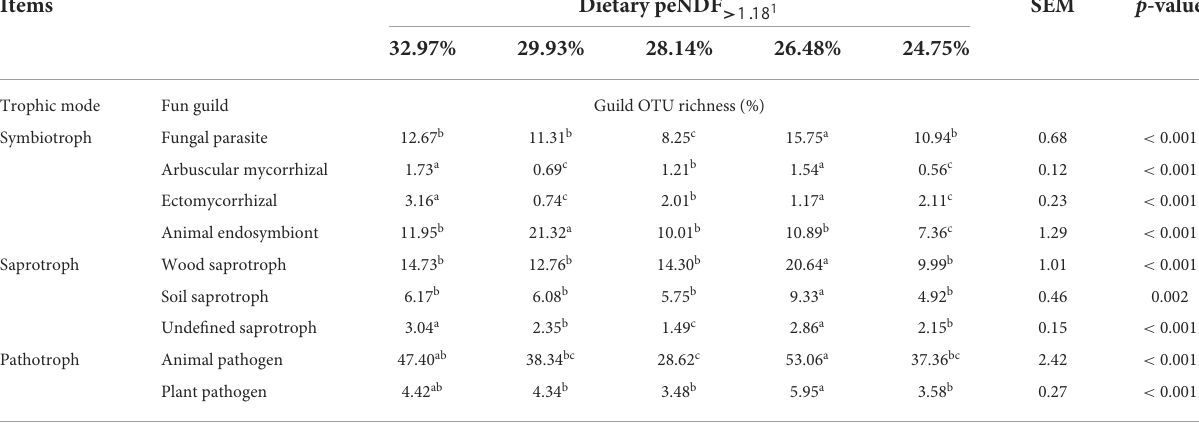
TABLE 10 Effects of dietary peNDF > 1.18 level on the prediction of rumen fungal functional guilds.